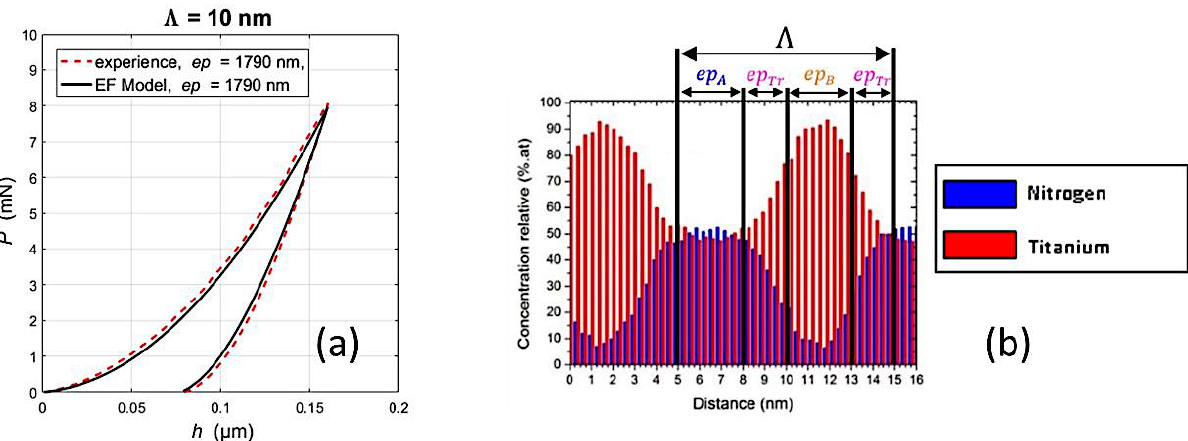
Figure 5. For Λ = 10 nm, (a) Comparison of the (P-h) experimental and simulated curves with a transition layer, (b) EELS